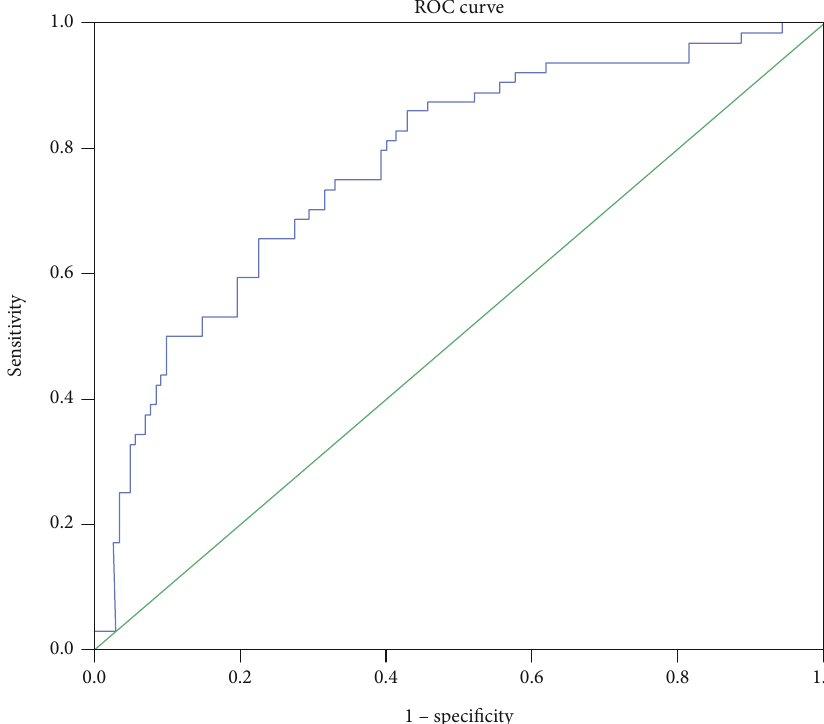
Figure 1: Receiver-operating characteristic curves for overall survival